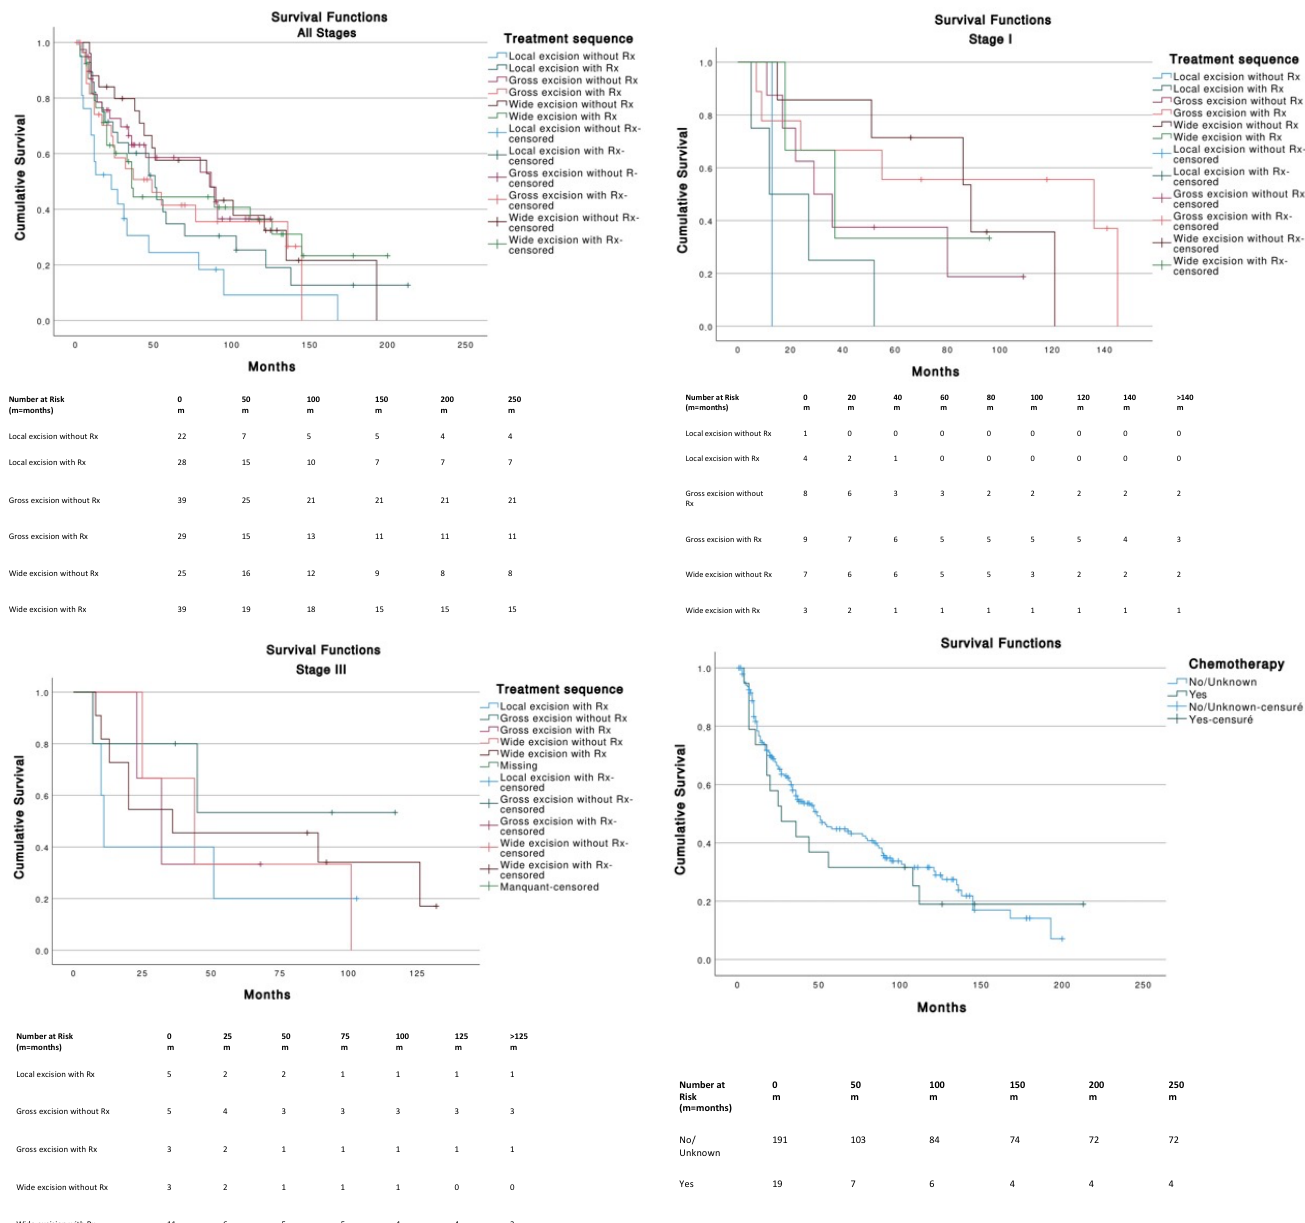
Figure 4. Tumor staging and therapeutic strategies survival curves.